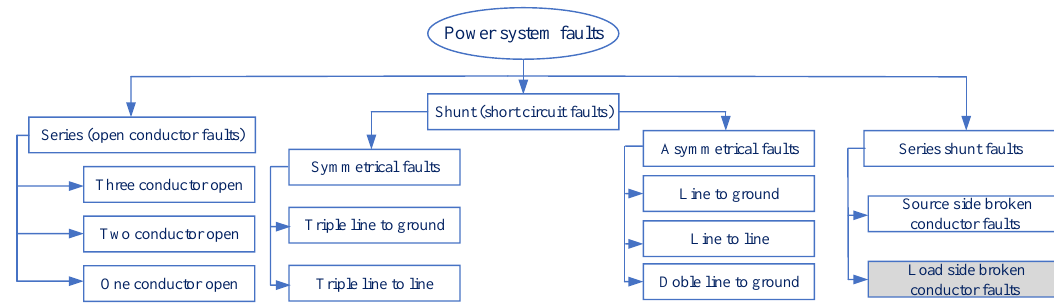
Figure 1. Classification of power system faults.